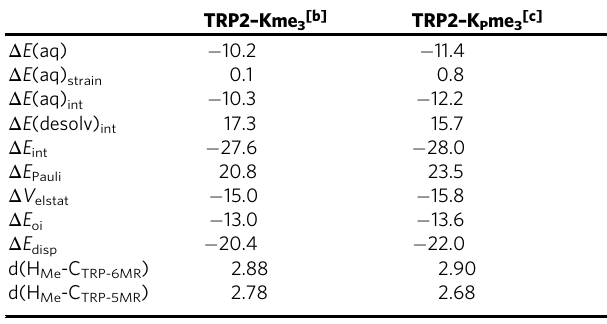
a Computed using BLYP-D3BJ/TZ2P with COSMO to simulate aqueous solution. Structural rigidity imposed by the protein backbone is simulated through constrained geometry optimizations. See Eqs. ( 1 – 3) in Supplementary Information. b TRP2 fi xed, Kme 3 free. c TRP2 frozen, α -methyl carbon of K P me 3 fi xed to position in TRP2-Kme 3